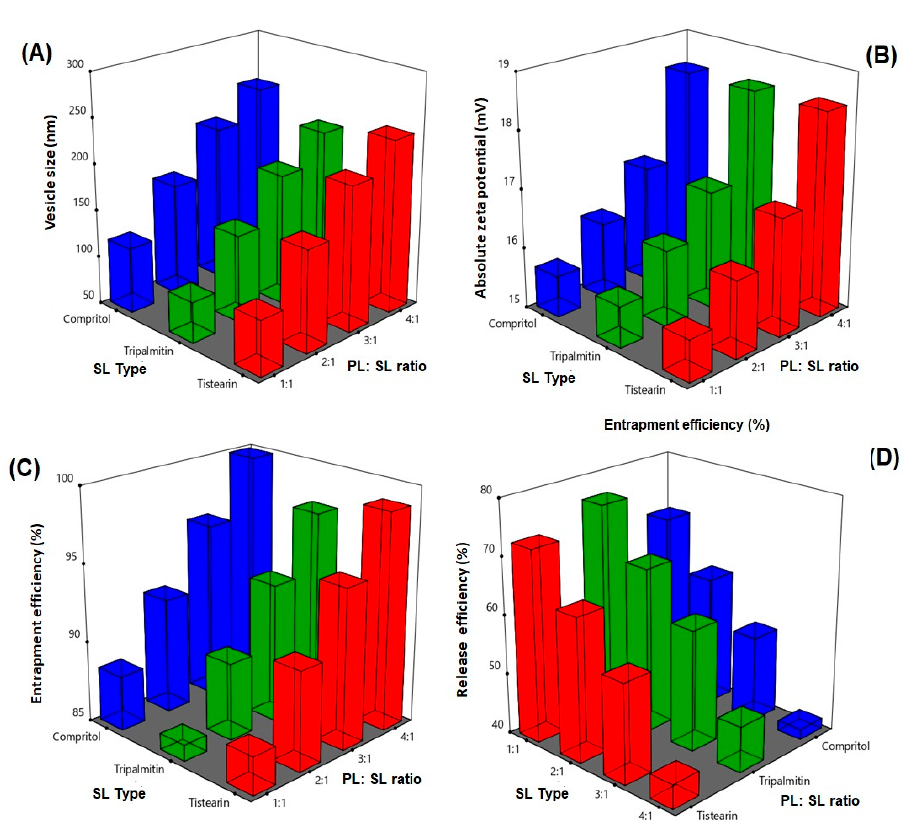
Figure 1. Response 3D plot for PL:SL weight ratio effect; X 1 and SL type; X 2 on ( A ) vesicle size; Y 1 , ( B ) zeta potential; Y 2 , ( C ) entrapment efficiency; Y 3 , and ( D ) release efficiency after 6 h; Y 4 of RLX-EMLs. Abbreviations: RLX-EMLs, raloxifene hydrochloride emulsomes; PL:SL, lipoid: solid lipid weight ratio; SL type: solid lipid type.